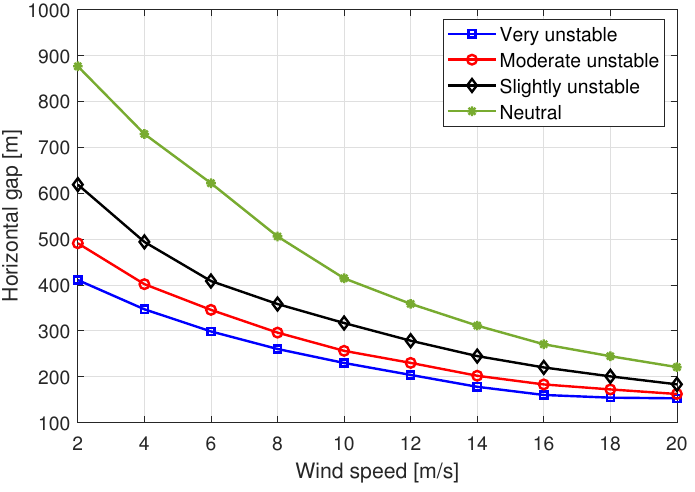
Figure 8. The horizontal gap for various stability situations as a function of wind speed. Figure 9 shows the relationship between the horizontal gap ∆ x and the emission rate factor κ . The parameter κ is used to represent the emission rate in terms of the reference emission rate, as specified by the formula Q i = κ i Q 0, i , ∀ i = { 1, 2 } . The symbols κ 1 and κ 2 represent the emission rate factors for PM2.5 and CO, respectively. This can show how increasing or decreasing the emission rates affects the horizontal gap. The horizontal gap grows as κ increases for the same emission rate factor κ = κ 1 = κ 2 , according to Figure 9. As a result, the proportional relationship between C and Q (1) was validated. As a result, as Q rises, as does ∆ x .